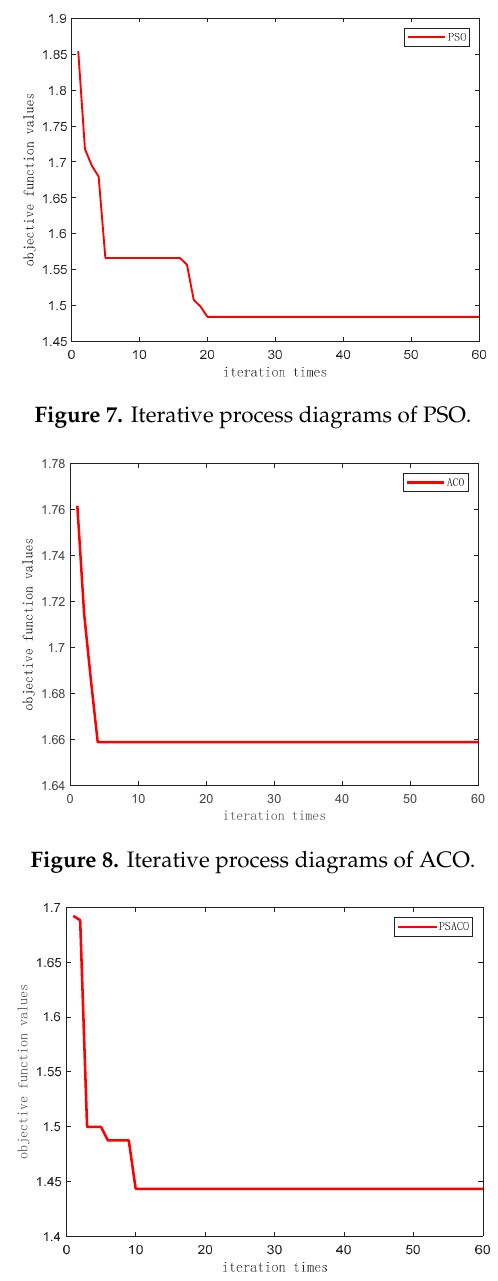
Figure 6. Optimization of parameters of ACO. ( a ) ant number; ( b ) pheromone coefficient; ( c ) heuristic coefficient; ( d ) pheromone volatilization coefficient. 6.2. Results and Discussion To study the performance of the proposed algorithm, we use MATLAB 9.40 (R2018a) software to carry out the experiments. Based on the simulation results, the proposed PSACO has been compared with PSO and ACO in detail. The specific results from the PSO, ACO, PSACO are shown in following figures. Figures 7–10 compare the search performance between the original ACO and PSO algorithms and the hybrid algorithm. The curves shown in the pictures describe the search processes up to the 60th iteration. We have two findings. Firstly, the three result curves of these algorithms have a similar tendency. The fitness value in the initial phase decreases sharply and searching efficiency reduces quickly in the final stages of the iteration. Secondly, the converging speed of PSACO is the fastest among the three algorithms. It is clearly reflected in Figure 10 when the three algorithms are shown in the same graph in which the black, blue and red curves represent PSO, ACO and PSACO respectively. The PSO’s searcher fitness value decreases gradually and unstably at the initial stage until it reaches its optimal solution of 1.4844 at the 20th iteration, revealing a defect that the algorithm tends to be trapped into local optima. The ACO’s searching fitness value quickly decreases and becomes stable at the 4 th iteration with its optimal solution of 1.6588. This states that ACO has the worst result for lacking available feedback information. As for the hybrid algorithm,